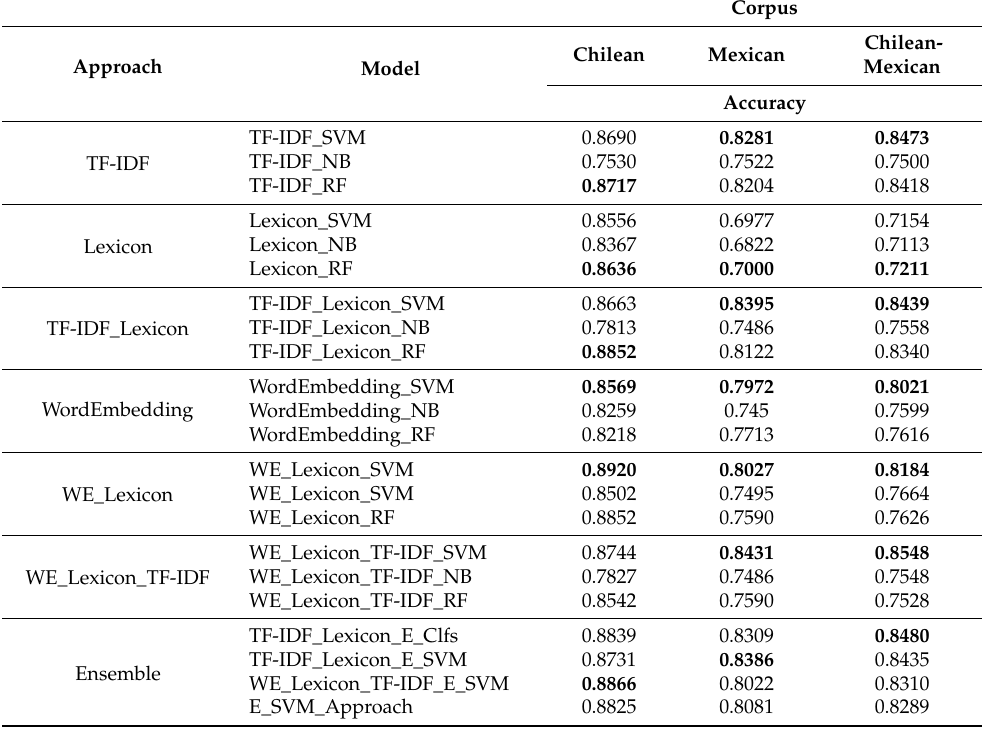
Table 7. Accuracy obtained by the models in the